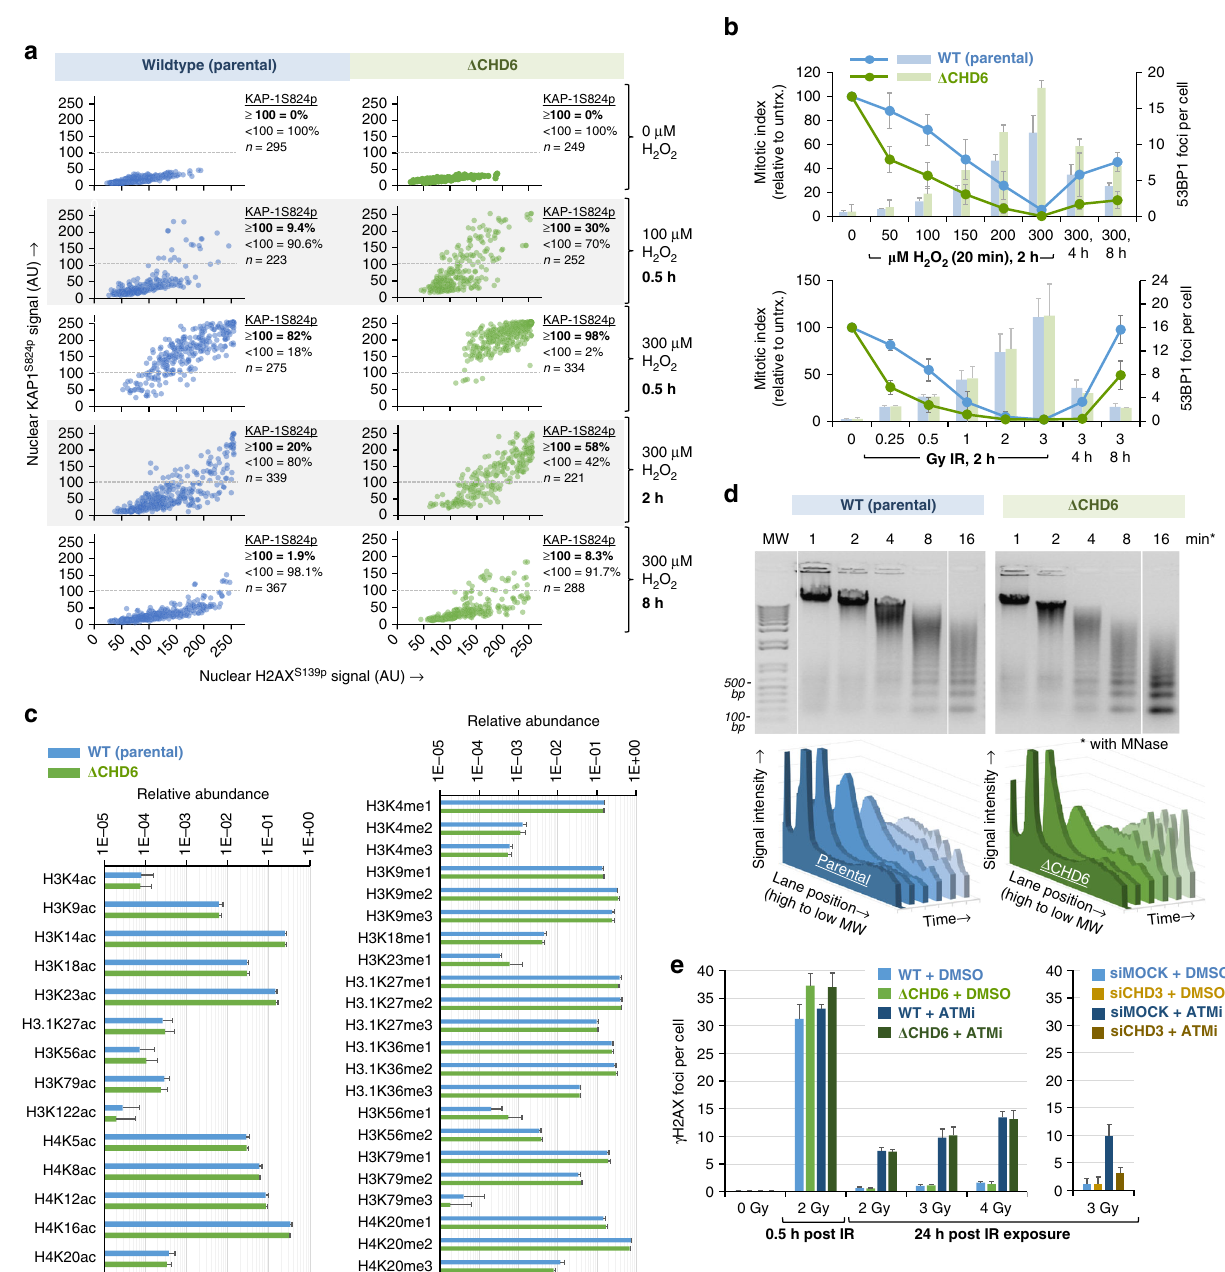
Fig. 6 CHD6-de fi cient cells have hypersensitive cell cycle checkpoint arrest, abnormally relaxed chromatin but functionally normal constitutive heterochromatin and epigenetics. a WT and A549 Δ CHD6 were exposed to 0 – 300 µ M H 2 O 2 in PBS for 20 min, washed, returned to media for 0.5 – 8 h, immunostained and quanti fi ed for nuclear KAP1 S824p and H2AX S139p signal (200 – 300 cells across n of 3). Percentage cells with ≥ or <100 KAP1 S824p signal (demarcating substantial DNA damage signaling) is indicated. Data represent n = 3. b WT and A549 Δ CHD6 were exposed either to 0 – 300 µ M H 2 O 2 in PBS for 20 min, washed, returned to media for 2 – 8 h, or irradiated with 2 Gy IR before being fi xed and immunostained for 53BP1 (demarcating DSBs), DAPI and H3 S10p (to demarcate G2/M phase cells). Mitotic indexes (lines, left y -axis) were derived from the % M-phase cells ( = strongly positive H3 S10p signal and DAPI morphology) relative to control. The 53BP1 foci per cell (bars, right y -axis) were also enumerated. Error bars = s.e.m.; n = 3. c 1 × 10 7 WT and A549 Δ CHD6 were processed via acid extraction to isolate histones, which were then derivatized with propionic anhydride, digested and quanti fi ed for the indicated epigenetic modi fi cations by mass spectrometry (see Methods). Error bars = s.d.; n = 6. d Nuclei isolated from con fl uent WT and A549 Δ CHD6 were exposed to MNase for indicated times before isolation and resolution of genomic DNA by agarose gel. Representative ethidium bromide-stained 1.2% agarose gels are shown (upper panels, inverted signal) alongside quanti fi ed DNA signal across each lane (lower panels) from a total of n = 3. e WT and A549 Δ CHD6 were transfected with scrambled, CHD6 or CHD3 siRNA 48 h before incubation with DMSO or 10 µ M ATMi 30 min prior to irradiation, fi xation at indicated times, γ H2AX immunostaining and foci enumeration. Error bars = s.e.m.; n = 3. In all cases, blue refers to WT cells; green refers to Δ CHD6 cells and yellow refers to WT cells treated with CHD3